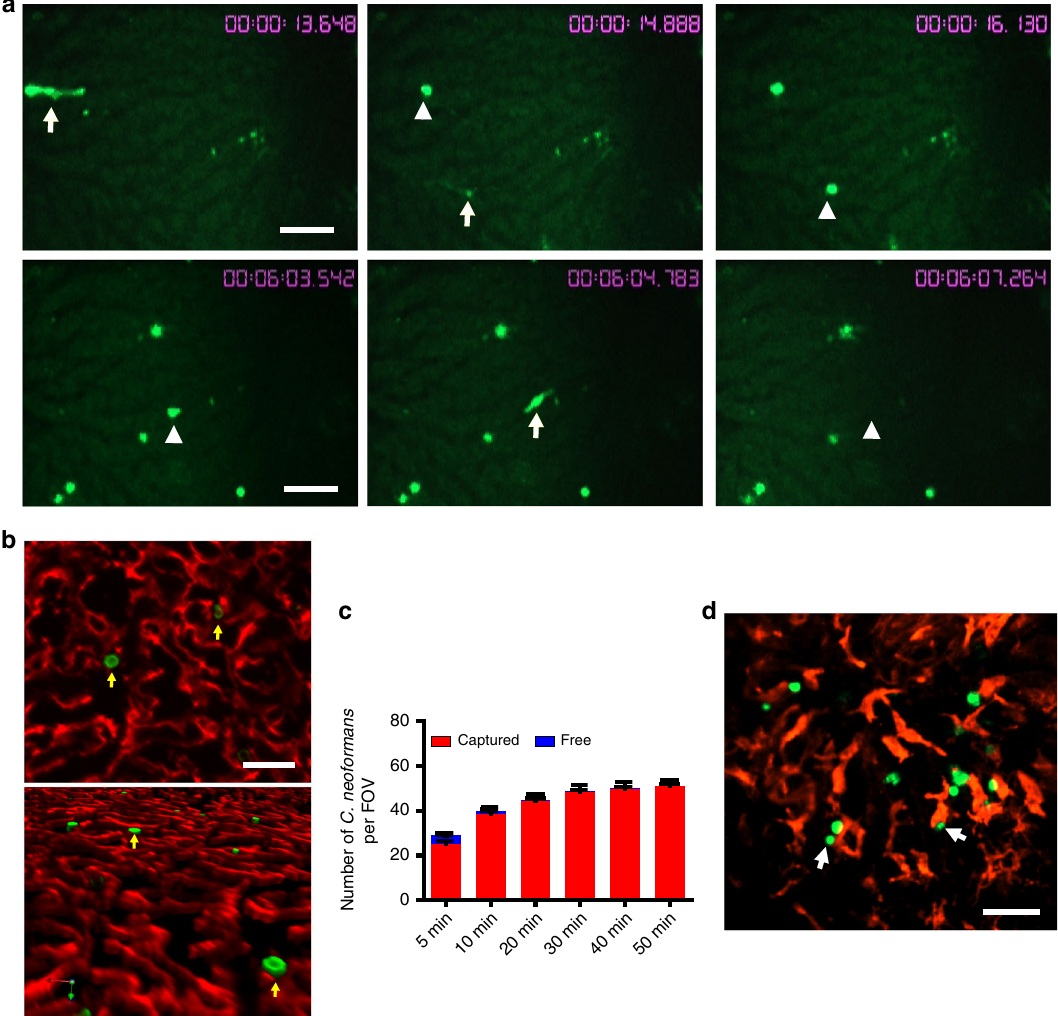
Fig. 1 The dynamics of the capture of circulating C. neoformans in the liver. IVM was performed on the liver of mice ( n = 5 mice) following i.v. injection of 100 × 10 6 GFP-labeled C. neoformans H99 via the tail vein. a A series of images taken by IVM showing the same fi eld of view after injection. Time in minutes and seconds after injection is shown in the images. Upper panel: a sudden stop of the yeast cells in the liver. Arrows indicate the moving yeast cells; arrowheads indicate the same yeast cells arrested in the next frame (1.2 s later). Lower panel: release of an arrested yeast cell. Arrowhead in the left image indicates an arrested yeast cell; arrow in the middle image indicates the same yeast cells leaving in the next frame (1.2 s later); arrowhead in the right image indicates absence of the yeast cells 2.5 s later. b Representative IVM images showing that C. neoformans (green) was arrested in liver sinusoids (endothelial cells were labeled with anti-PECAM-1 mAb; red) after i.v. infection with GFP-labeled C. neoformans . Upper panel: 2D image; lower panel: 3D image. c The number of captured and free C. neoformans in a fi eld of view at various time points after injection. At indicated time points, the number of yeast cells captured (being stationary for >3 s) and free yeast cells traveling in the bloodstream were counted. Data are from biologically different mice ( n = 5 mice, one FOV per mouse). d PE conjugated anti-F4/80 mAb was injected into the tail vein for staining of liver KCs (red); most yeast cells (green) were associated with KCs. Scale bars: 25 µ m. Data are expressed as mean ± SEM of two independent experiments. Source data are provided as a Source Data fi